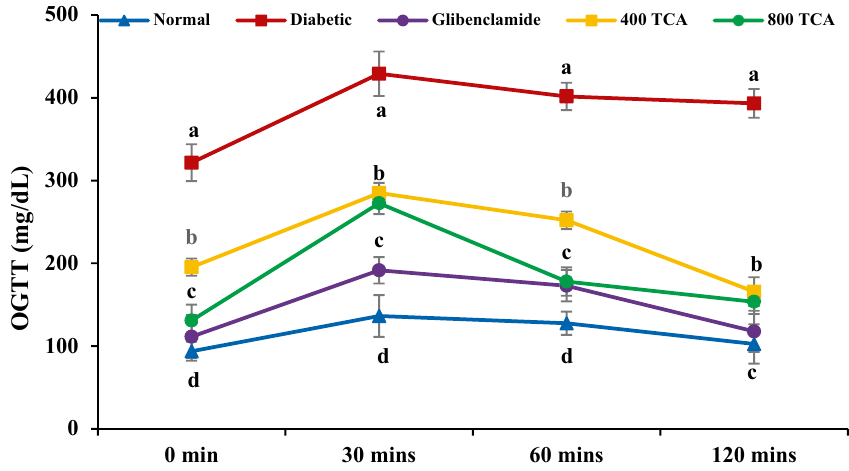
Figure 4. Effect of T. catappa aqueous extract treatment on HFD/STZ-induced diabetic rats’ oral glucose tolerance test. Markers are expressed as mean ± SEM (n = 6). Markers with different superscripts per time are significantly different at p < 0.05. Markers with similar superscripts per time are not significantly different at p < 0.05.